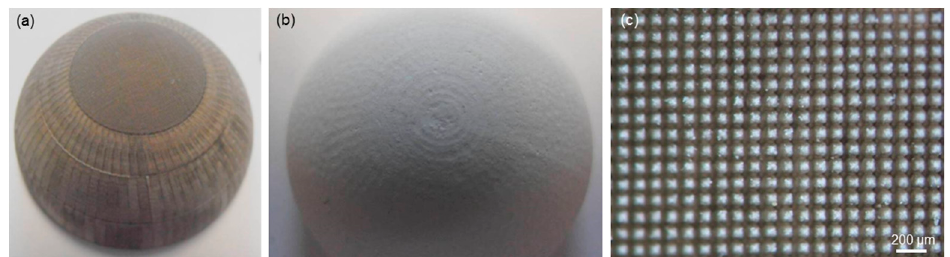
Figure 15. Laser-textured ceramic cup: ( a ) sample after laser treatment, ( b ) sample after thermal treatment in an oven at 700 °C, ( c ) optical micrograph of the surface.